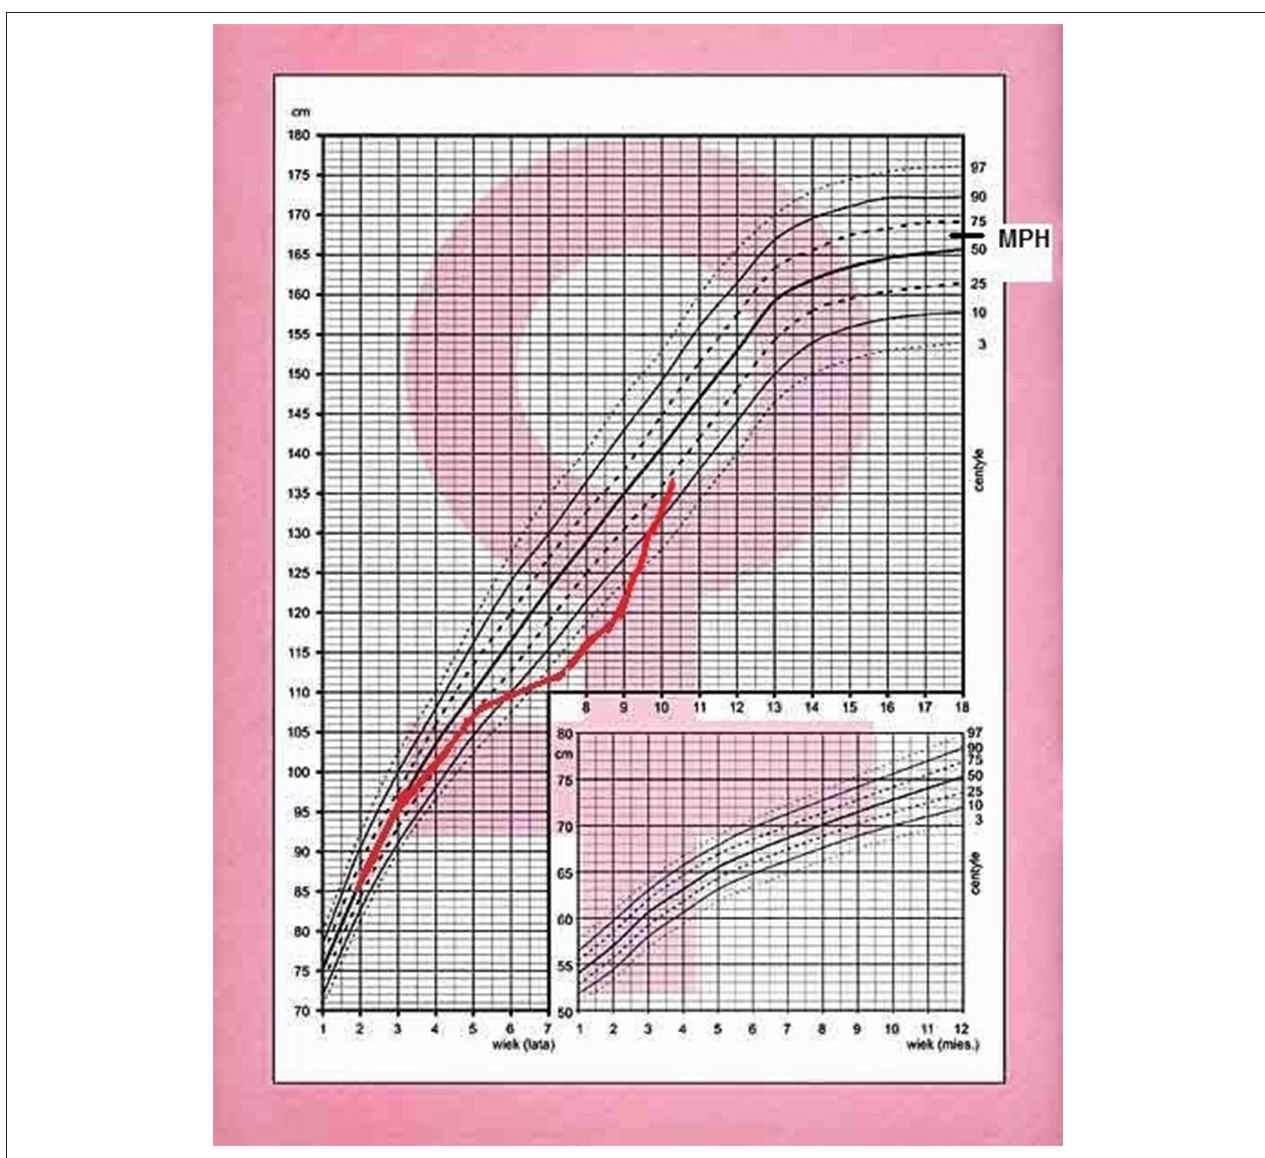
FIGURE 1 | Growth chart of the patient with cyclic Cushing’s